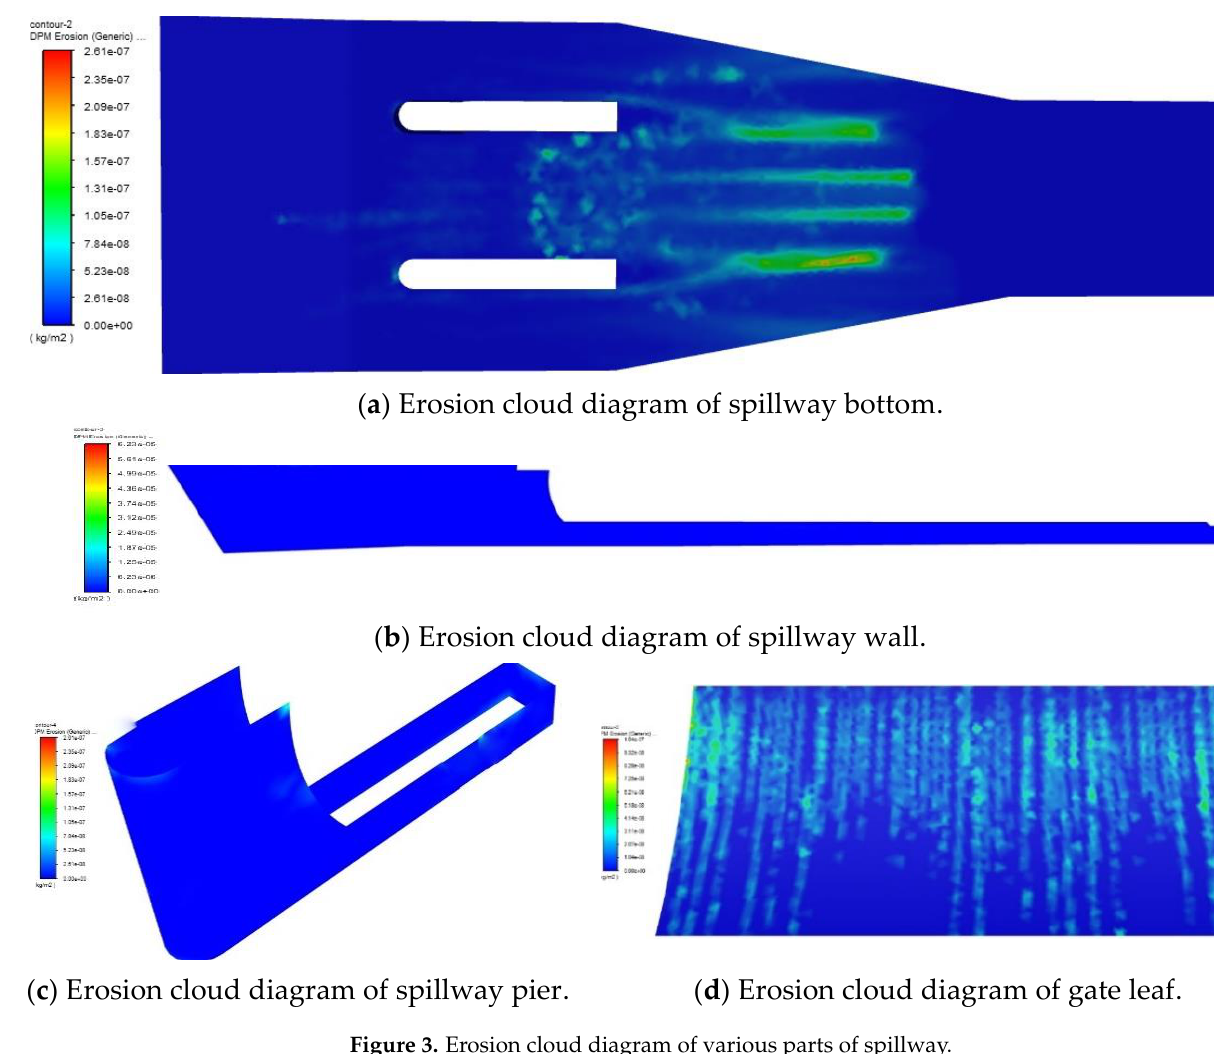
Figure 3. Erosion cloud diagram of various parts of spillway.